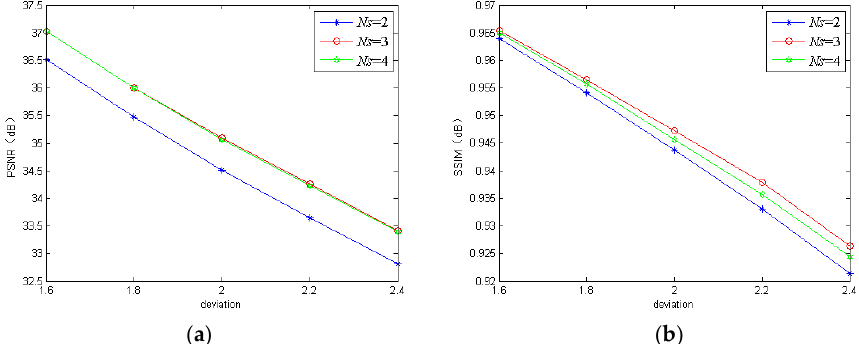
Figure 4. The peak signal-to-noise ratio (PSNR) and structural similarity (SSIM) of the proposed model using different numbers of scales on the realistic and dynamic scenes (REDS) dataset: ( a ) PSNR; ( b ) SSIM.